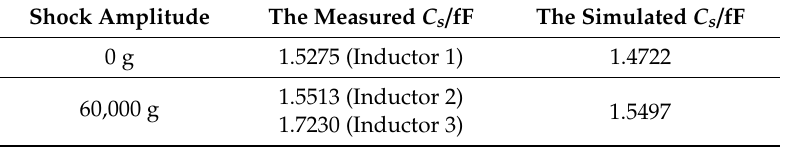
Shock Amplitude